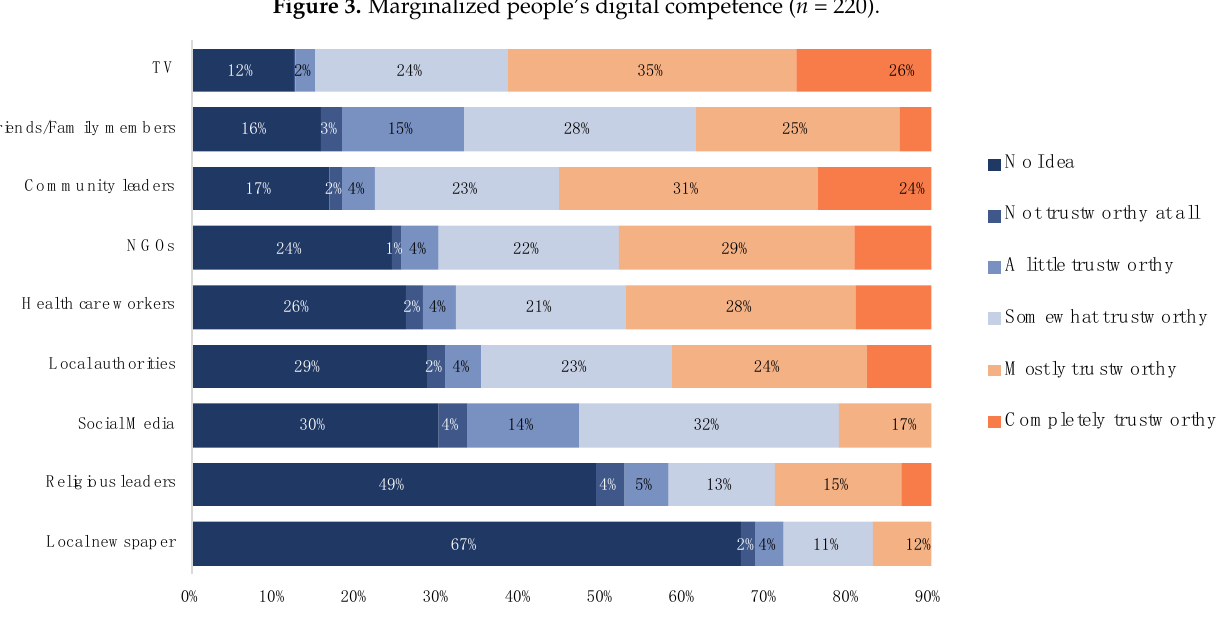
Figure 4. Reliability of COVID-19 information sources. (Five scales: lowest trust (darkest color) to highest trust (lightest color) ( n = 453).